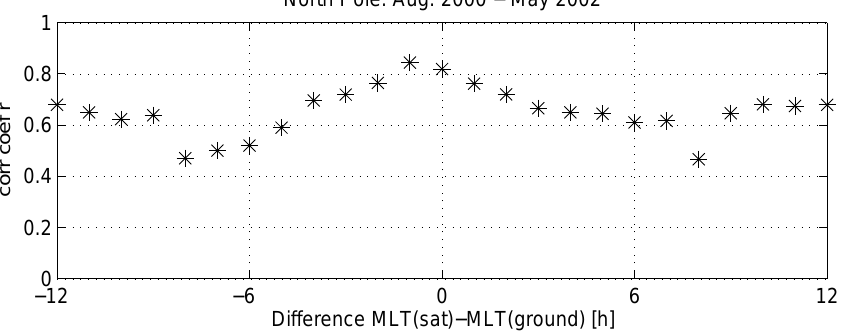
Fig. 5. Cross correlation analysis between the ionospheric Hall currents (IHCs) determined from CHAMP and the IMAGE- AE index with respect to the difference in magnetic local time for all